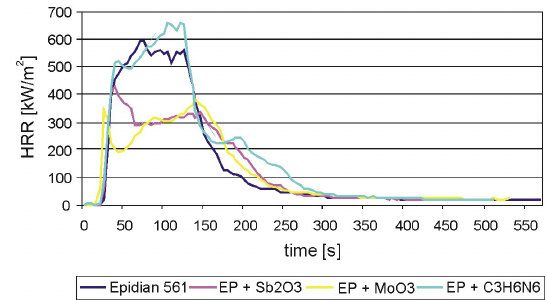
Fig. 2. The heat release rate (HRR) curves of unmodified (EP) and modified epoxy material at external flux of heat 50 kW/m